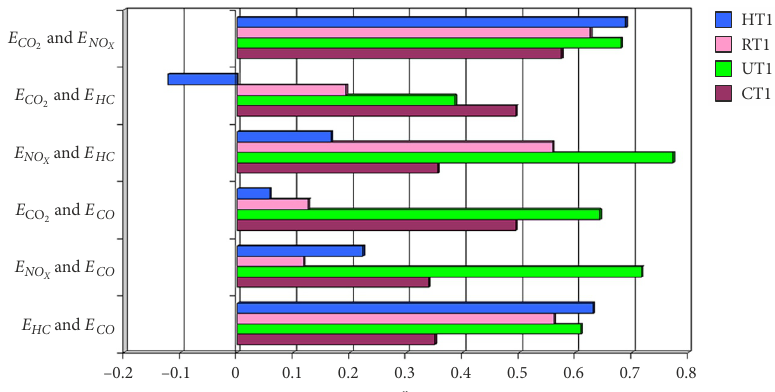
Figure 19. Coefficient of Pearson’s linear correlation r between the emission intensity of specific pollutants